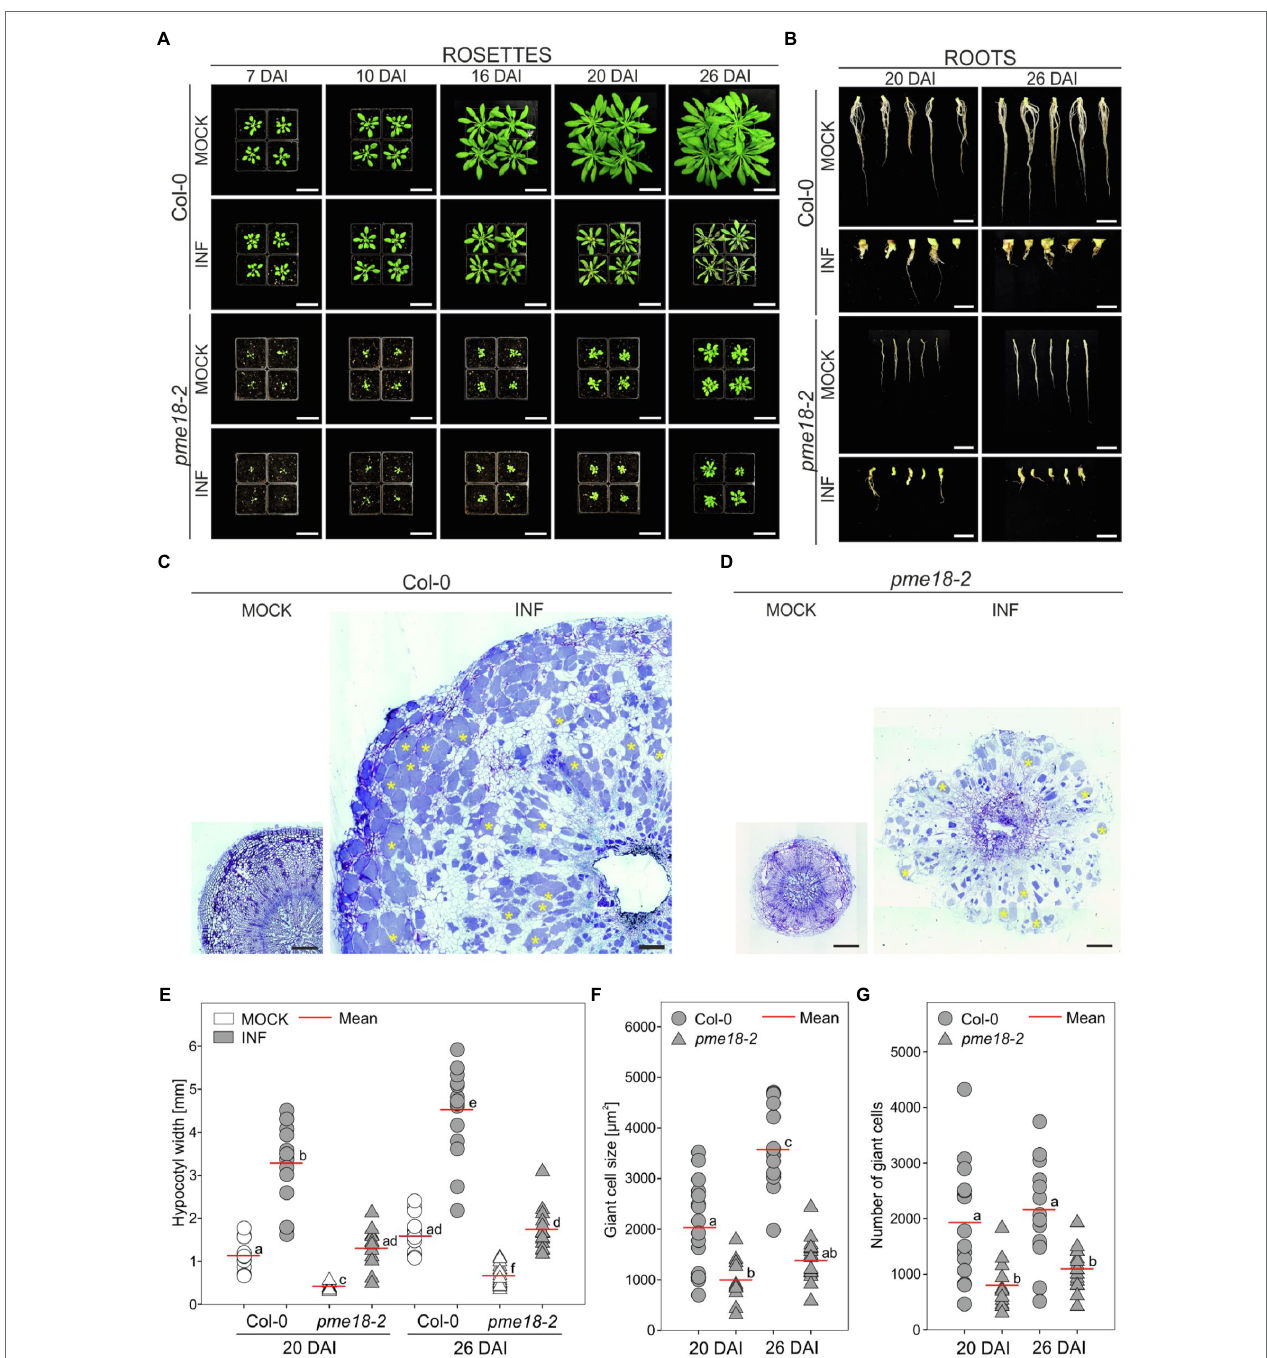
FIGURE 3 | Clubroot disease development in wild-type Col-0 and pme18-2 . The effects of disease progression on the morphology of aerial parts (rosettes) 7, 10, 16, 20 and 26 DAI (A) , and roots 20 and 26 DAI (B) . Scale bars represent 5 cm for rosettes and 1 cm for roots. (C,D) Representative transverse 5 μ m sections across hypocotyls of Col-0 (C) and pme18-2 (D) plants 26 DAI. Exemplary cells filled with resting spores are indicated with yellow asterisks. Sections were stained using toluidine blue. Scale bars represent 200 μ m. (E) Hypocotyl width in mock- and P. brassicae- inoculated Col-0 and pme18-2 plants 20 DAI and 26 DAI. Scatter plots present individual hypocotyl width measurements (between seven and 17 replicates for each combination), calculated means and SEs. Different letters indicate significant differences between means (Tamhane’s test, p < 0.05). (F) The influence of the pme18-2 mutation on the size of enlarged cells 20 DAI and 26 DAI. Scatter plots present individual measurements performed on radial sections of 7 to 17 independent hypocotyls for each combination, calculated means and SEs. Different letters indicate significant differences between means (Tamhane’s test, p < 0.05). (G) The influence of the pme18-2 mutation on the number of giant cells 20 DAI and 26 DAI. Scatter plots present individual calculations of enlarged cells for 7 to 17 radial sections taken from independent hypocotyls for each combination, calculated means and SEs. Different letters indicate significant differences between means (Tamhane’s test, p <